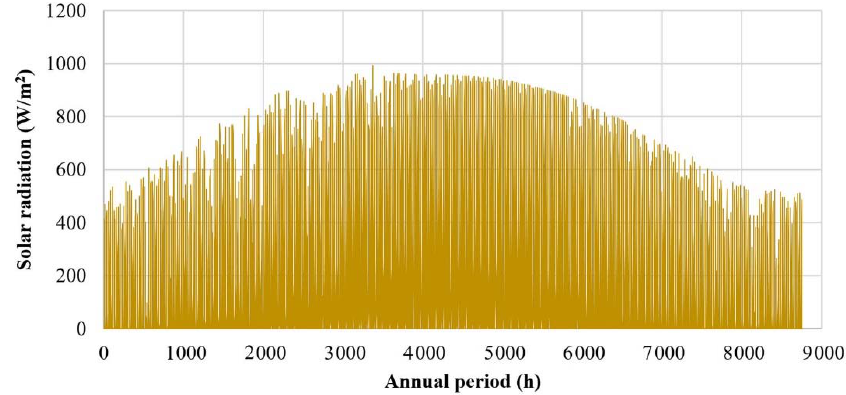
Figure 3. The annual time series of the available incident solar radiation on horizontal plane at the town of Arkalochori.